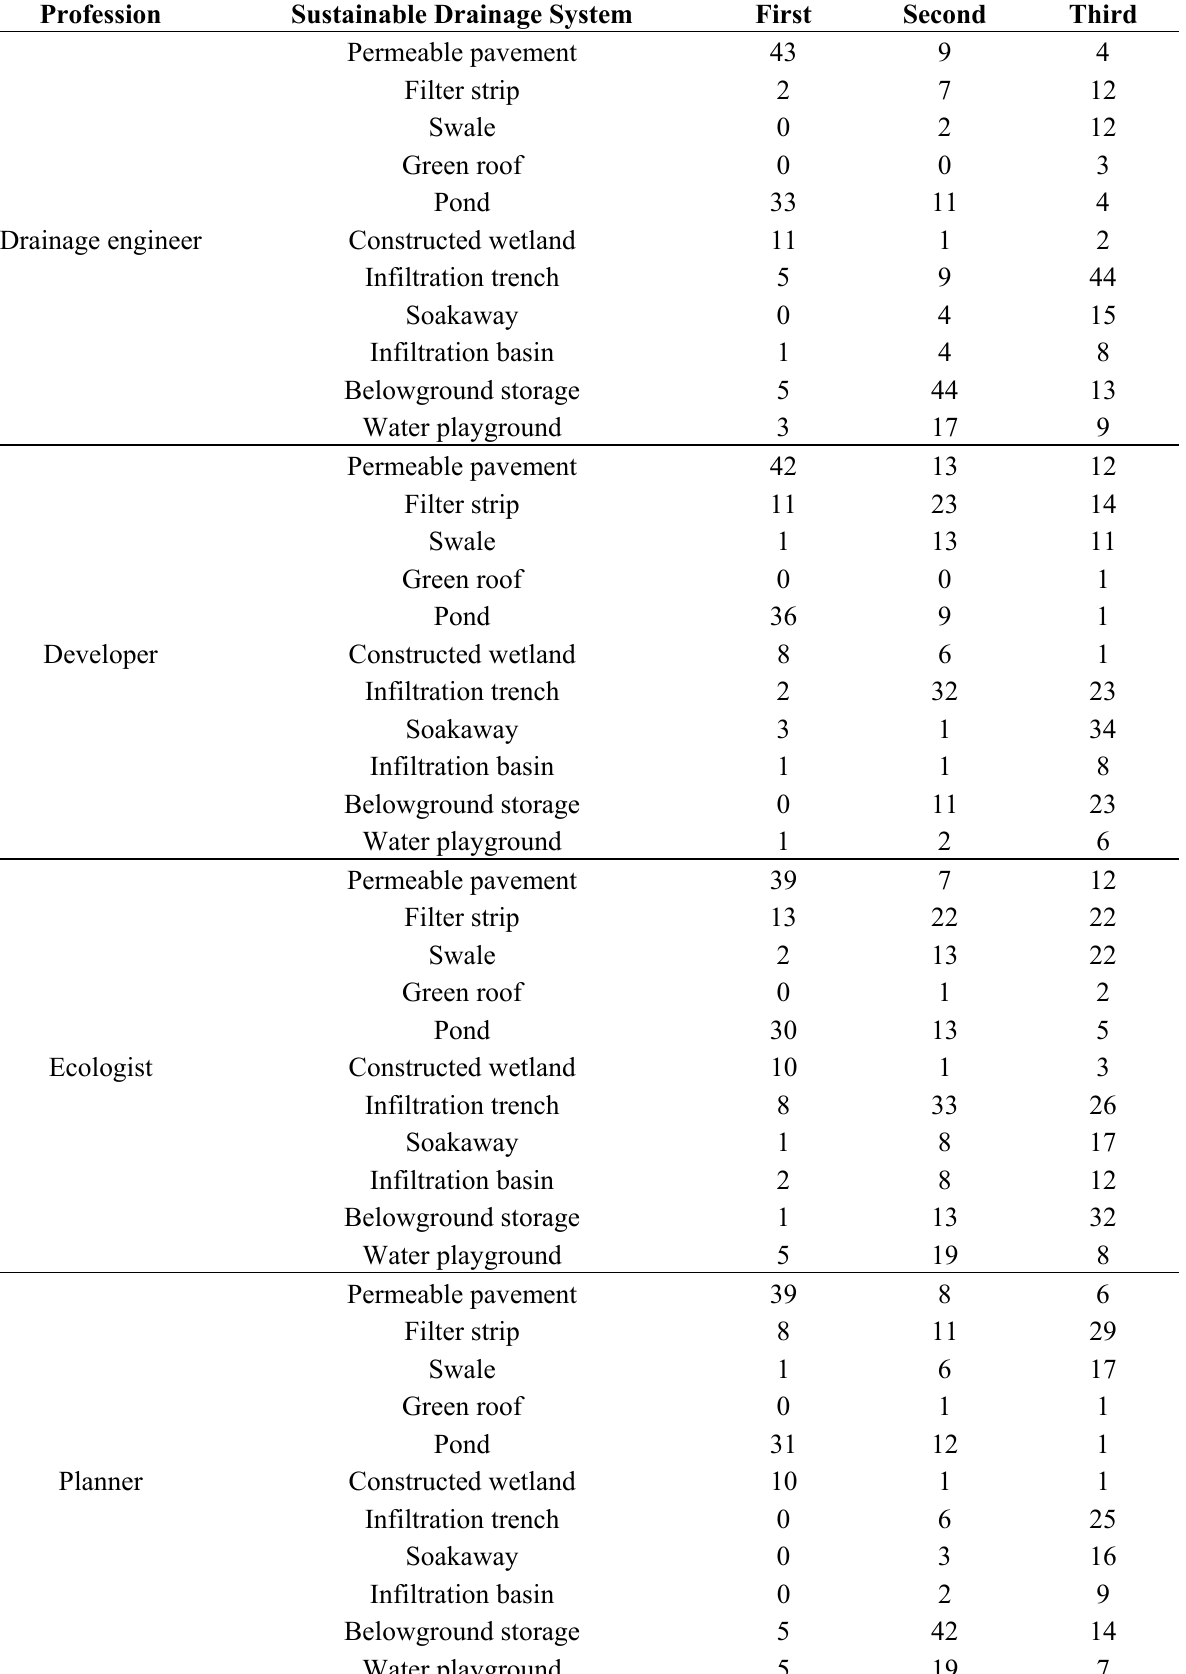
Table 4. Drainage system